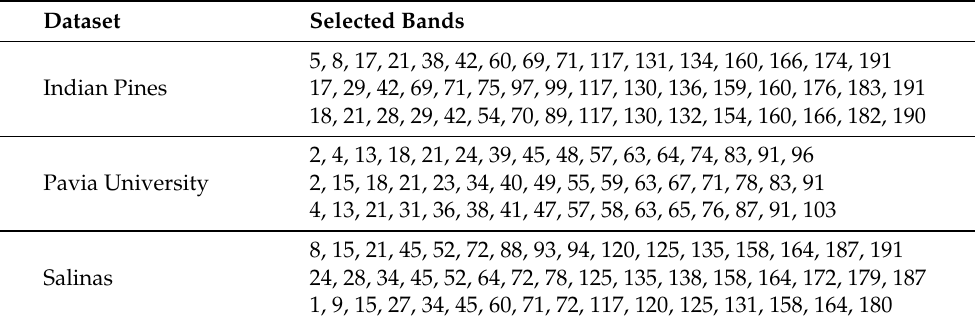
Table 4. Selected bands by the proposed method on three datasets when the dimension is 16. Dataset